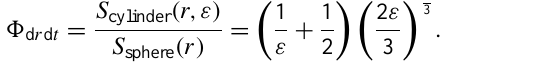
0 . 1), the values are closer to 1 than for ε = 10, indicating that “disc”-shaped particles affect NLC microphysics more than “needle”-shaped ones. Using a smaller range of parti- Hervig and Gordley (2010) leads to (cid:56) d r d t < 1 . 3 and (cid:56) sedi > 0 . 7. Both correction factors differ from 1 for ε = 1: cylin- drical particles with equal diameter and height grow faster and fall more slowly than spherical particles. Also shown in d r | | Fig. 2, d r spheroid < cylinder for ε values close to 1. Only d t d t oblate spheroids with ε > 4 grow faster than flattened cylin- ders at the same axis